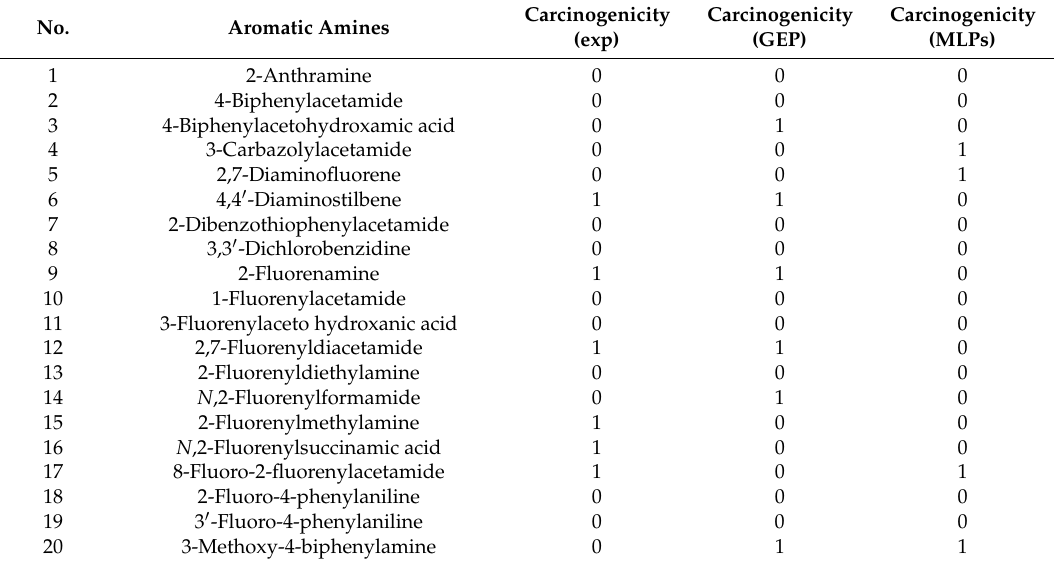
Table 2. Carcinogenic activity of aromatic amines for test